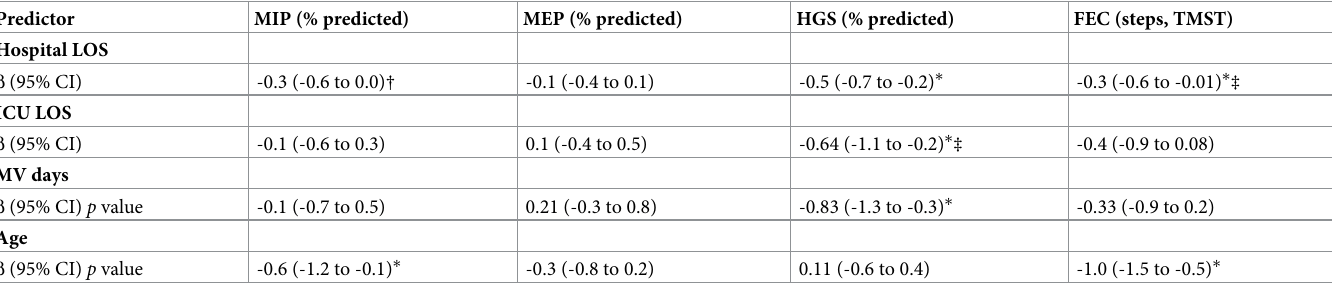
Table 3. Longitudinal associations between predictor variables and